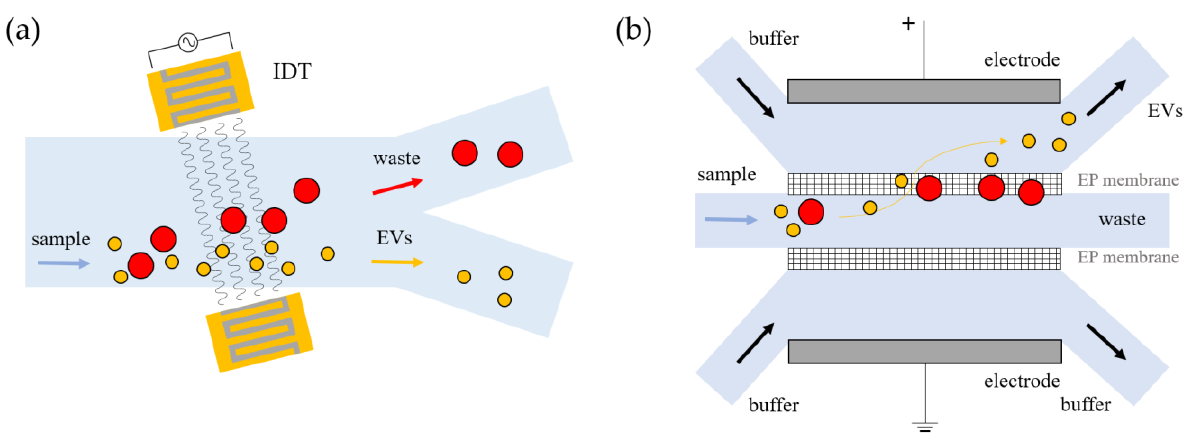
Figure 4. Examples of physical forces to separate vesicles within microfluidic chips. ( a ) Device with interdigitated electrodes generating acoustic waves to separate EVs from the initial sample; ( b ) differentiation of EVs through membranes mediated by electrophoretic (EP) forces.